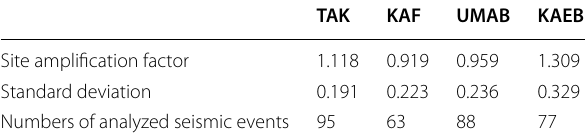
Table 1 Site amplification factors referenced to